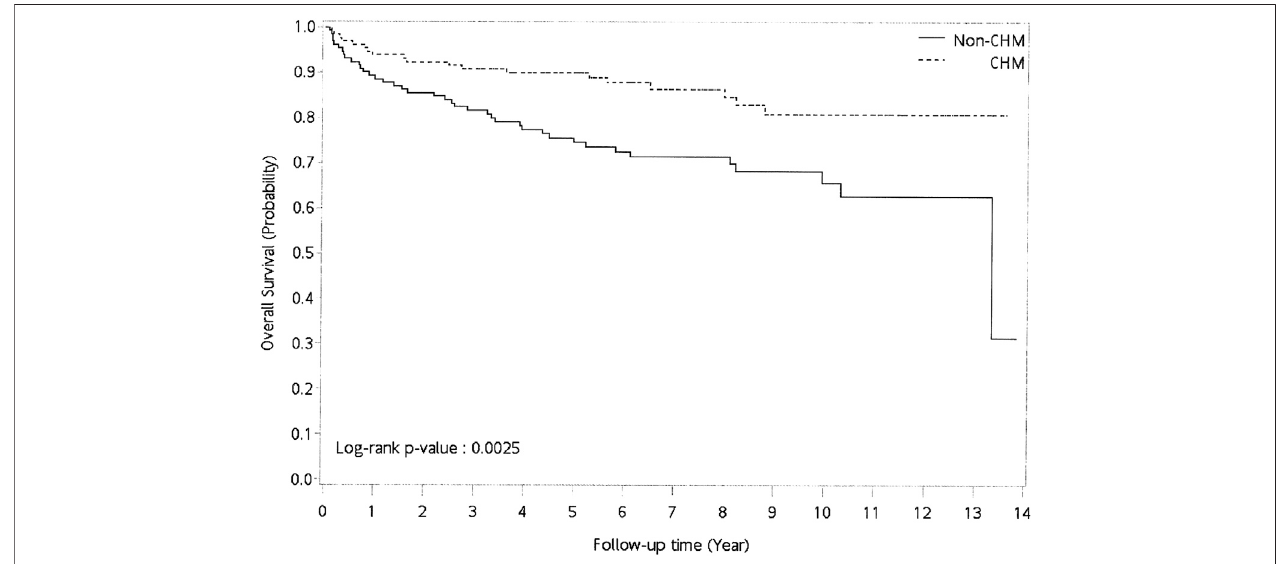
FIGURE2| CumulativeincidenceofoverallsurvivalbetweenCHMandnon-CHMusersinpatientswithpemphigus.Abbreviations:CHM,Chineseherbalmedicine.